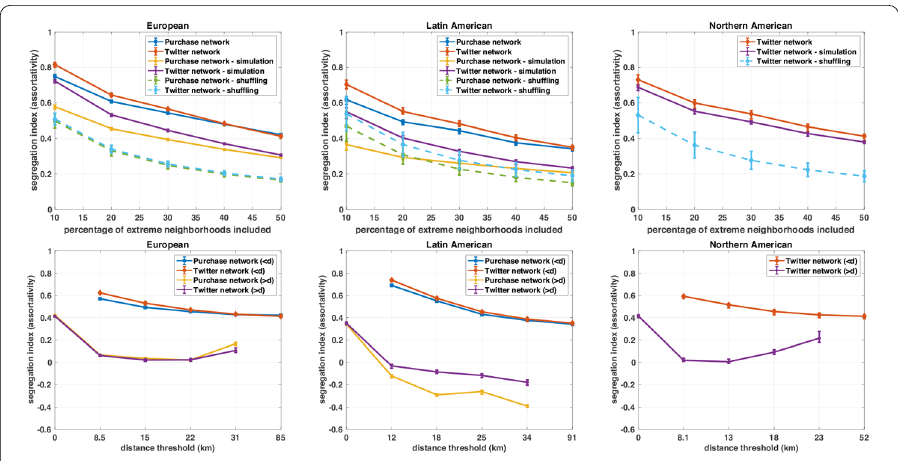
Figure 3 (Top) The assortativity for different networks, as a function of the percentage of neighborhoods with extreme socio-economic status included in computation. (Bottom) The assortativity for different networks, as a function of the distance thresholds used for pruning edges in the interaction networks. The error bars in the green and cyan curves correspond to the standard deviations, and all other error bars correspond to the 95% confidence interval using a jackknife resampling technique as in